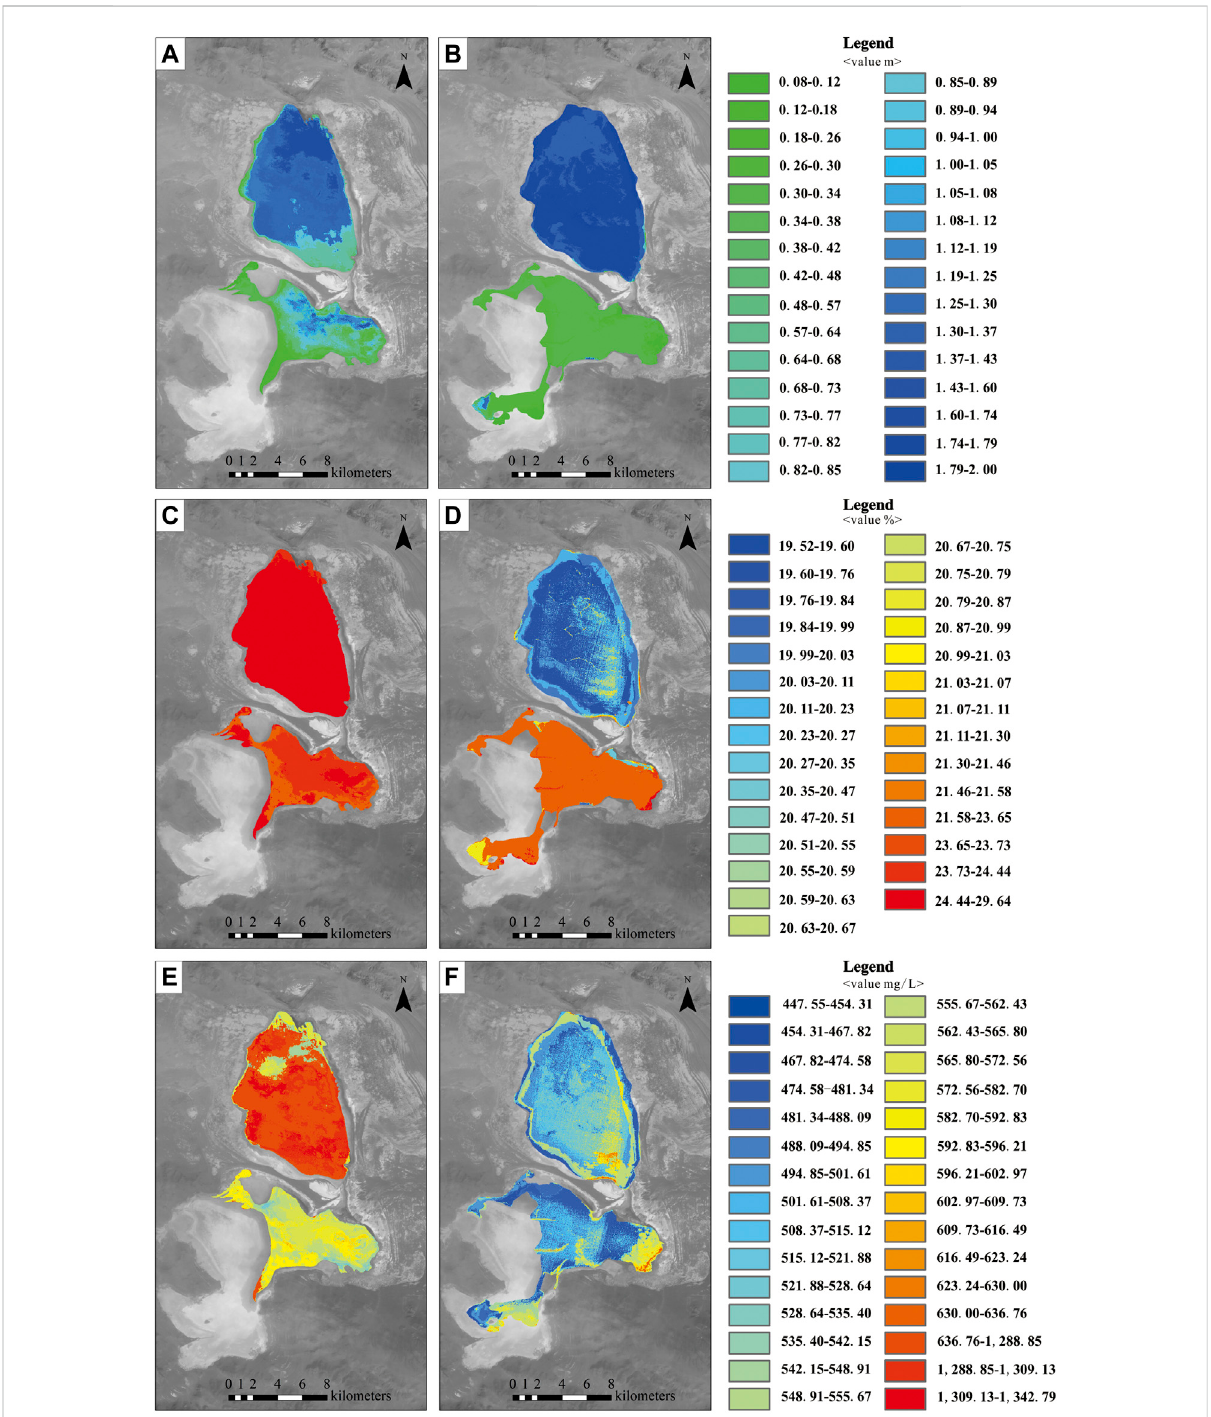
FIGURE 5 Waterdepth,salinityandlithiumconcentrationinversionresults.Waterdepthin (A) 2000and (B) 2017;Salinityin (C) 2000and (D) 2017;Lithium concentration in (E) 2000 and (F)